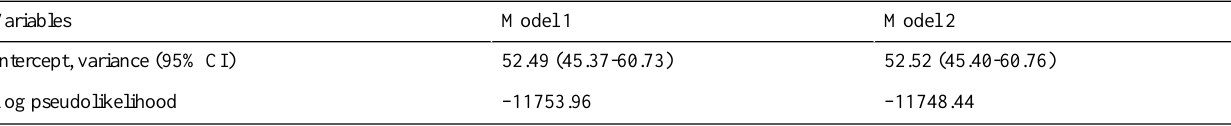
Table 4. Within-between models predicting changes in work engagement with time: random